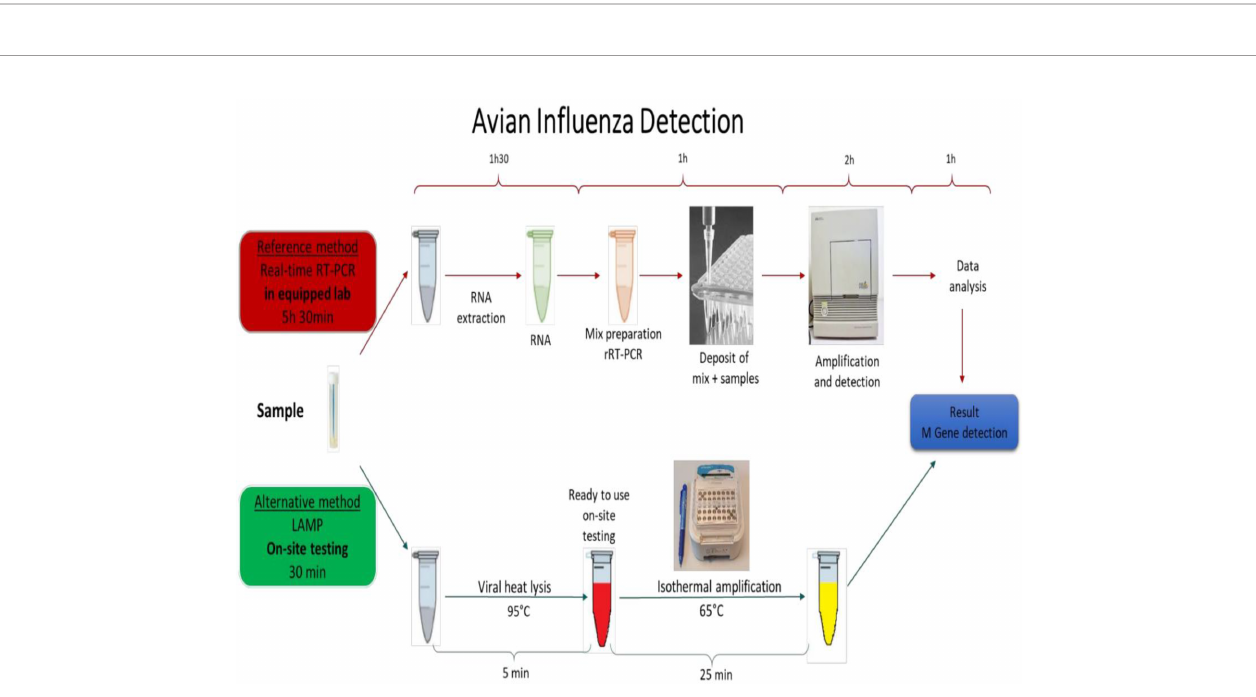
FIGURE 2 | Comparing rRT-LAMP, on-site test and rRT-PCR methods for AIV detection, 23 AIV strains and 3 non-AIV avian strains were tested. The gel electrophoresis image of rRT-LAMP (A) and RT-PCR products (B) . The ampli fi ed curves in rRT-LAMP (C) . The results of the on-site test (insert Figure in C ) and the rRT-PCR ampli fi cation curve (D)